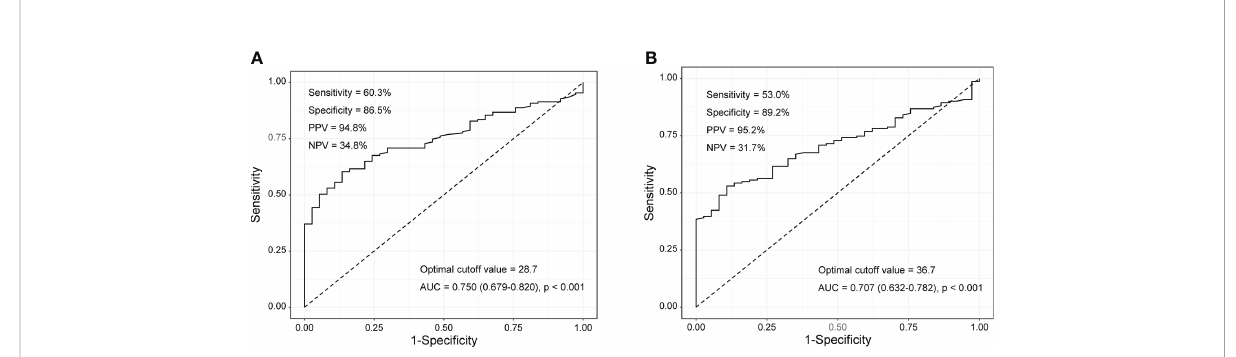
FIGURE 6 Tumour M2-PK cut-off levels for differentiating RA from OA and controls. Tumour M2-PK levels of 28.7 and 36.7 could be used to differentiate between (A) RA and OA patients, and (B) RA patients and controls, respectively. The optimal cut-off values were derived using the receiver operating characteristic curve. Tumour M2-PK: dimeric form of pyruvate kinase M2; RA: rheumatoid arthritis; OA: